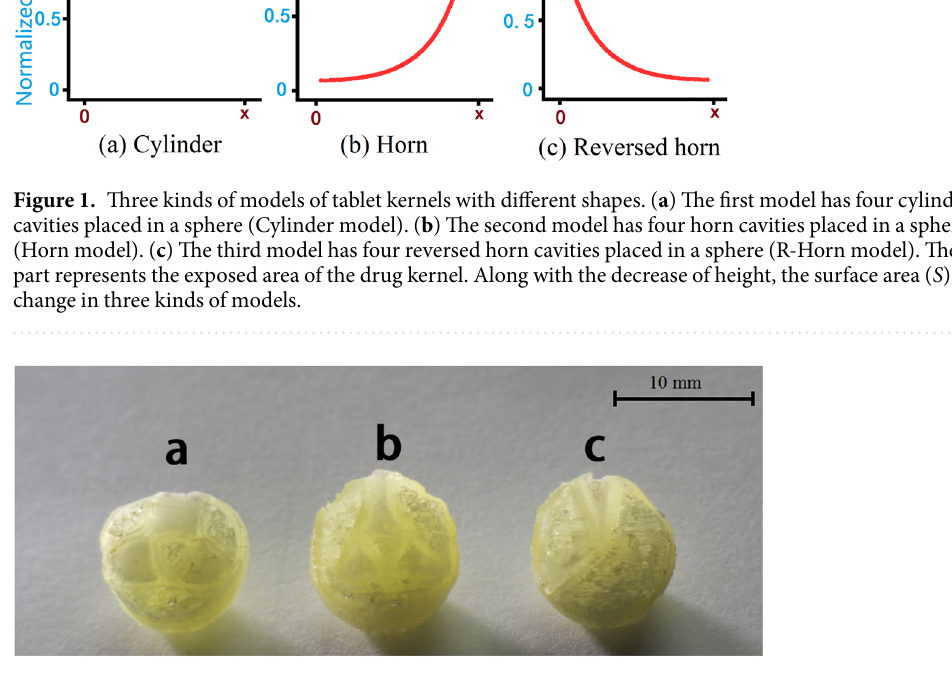
Figure 2. Photos of 3D printed tablets with the three models. ( a ) Cylinder model, ( b ) Horn model, ( c ) R-Horn model.